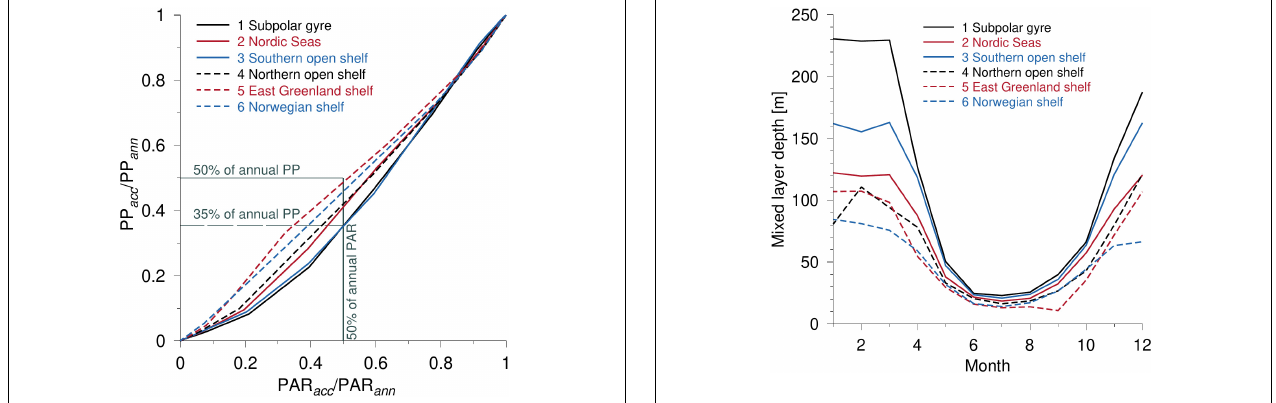
FIGURE 7 | The ratio of monthly accumulated PP (PP acc ) and the annual PP (PP ann ) vs. the corresponding ratio of PAR, i.e., PAR acc /PAR ann for the six subdomains. Gray lines indicate the 50% level of the annual PP and PAR and the 35% PP-level is shown with a dashed gray line.